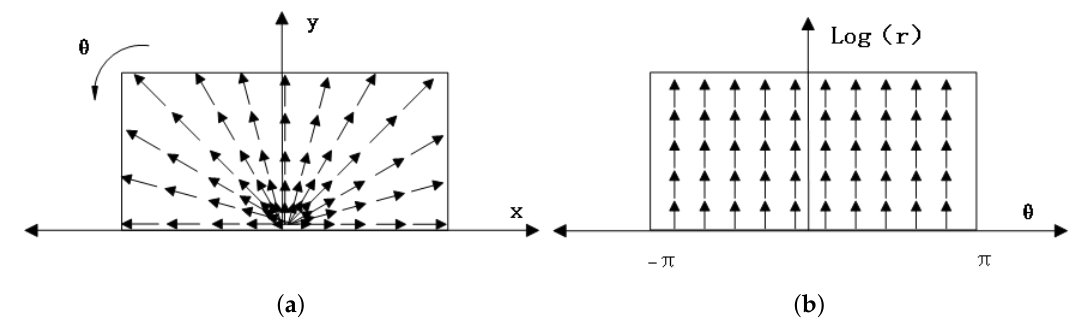
Figure 4. The diagram of the log-polar transformation: before ( a ) and after( b